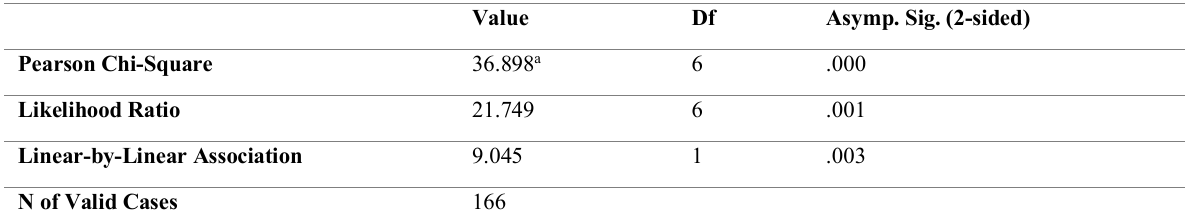
Table 4 : Chi-Square test on government policy